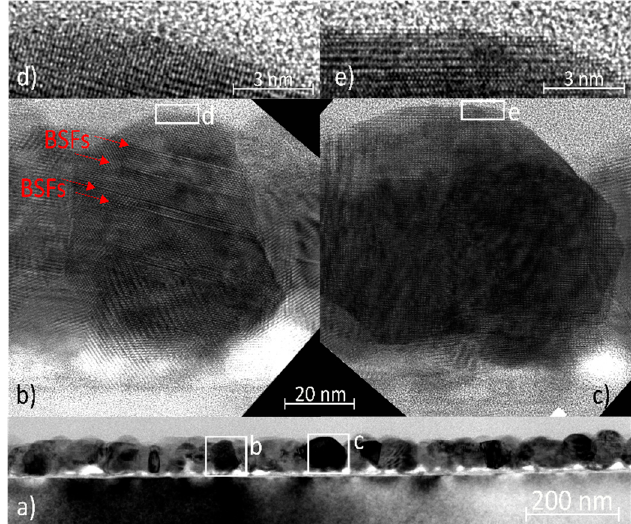
Figure 5. Transmission electron microscopy images of the seed layer ( a ), and of particular crystallites of the seed layer ( b , c ) preheated at 400 °C and annealed in the air at 600 °C and the corresponding HRTEM images ( d , e ) show a plane surface without any visible surface steps.